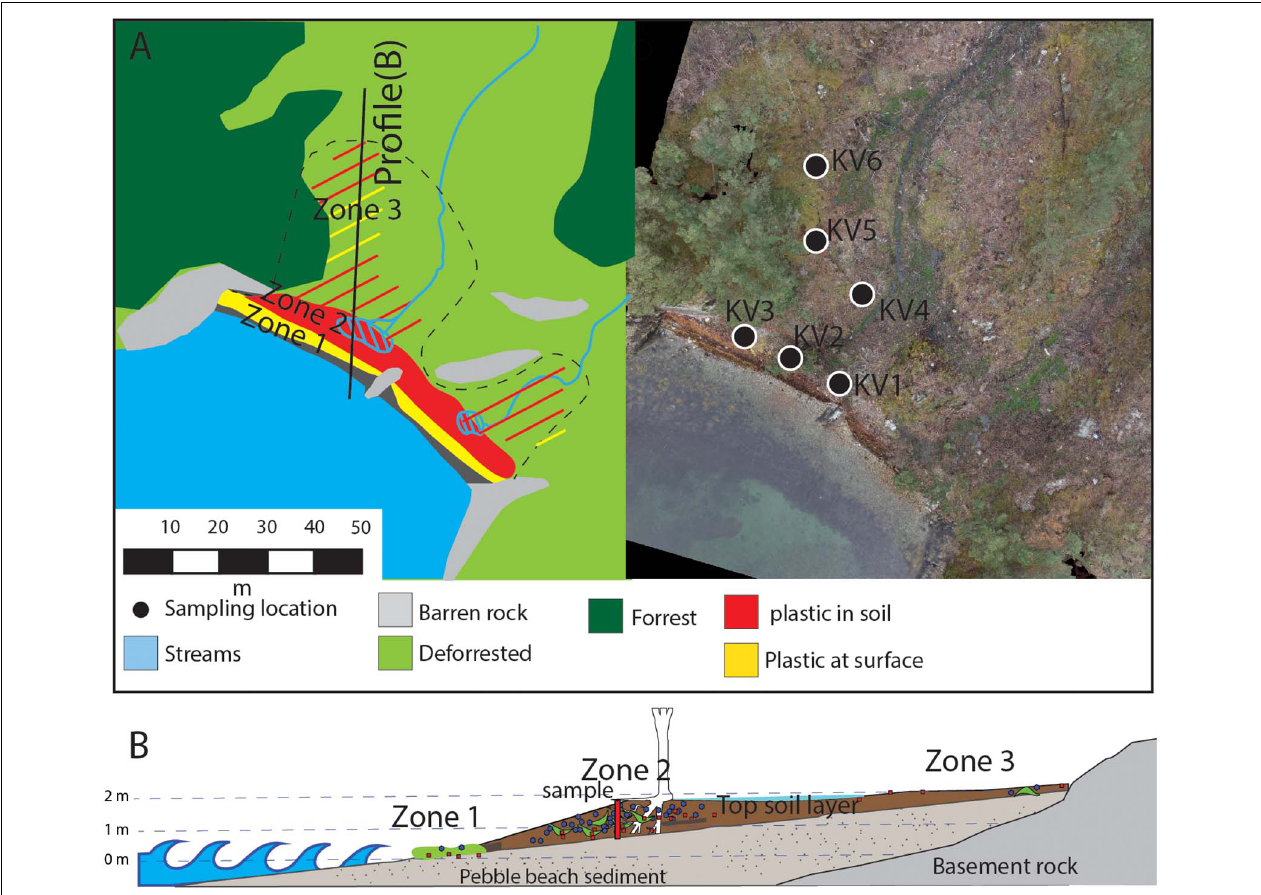
FIGURE 8 | (A) Map of the Kolavika location from high resolution drone images acquired in autumn of 2019. The map illustrates the distribution of deposits in zones 1, 2 and 3 (B) Profile from the shoreline and 50 meters onshore illustrating the soil thickness and plastic litter distribution in the substratum.